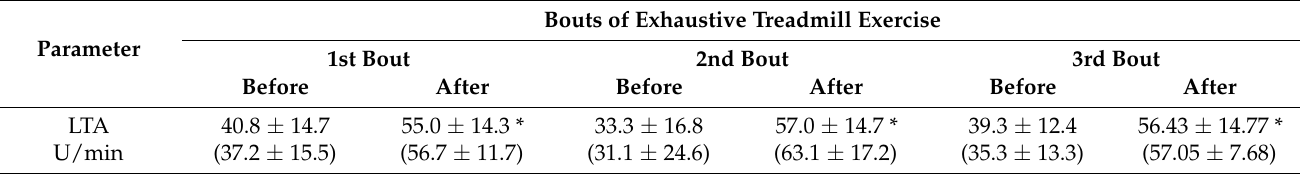
Table 2. Level of LTA status before and after each of three bouts of exhaustive treadmill exercise. Bouts of Exhaustive Treadmill Exercise Parameter